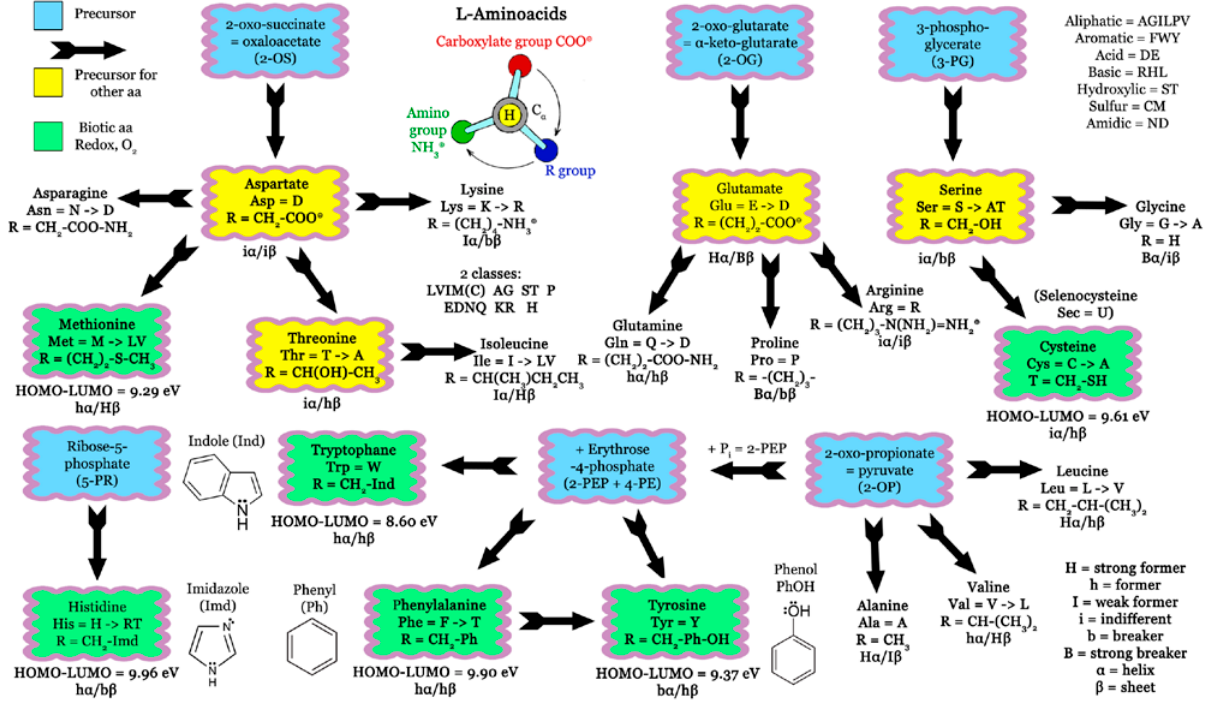
Figure 5. Relationships between the twenty aminoacid within their 3-letters and 1-letter codes, possible substitutions in proteins and sec- ondary structure (helix or sheet) preference. Primary organic precursors are highlighted in blue, secondary aminoacid precursors of other aminoacids are highlighted in yellow. Aminoacids added lately to the universal genetic code under oxic conditions are highlighted in